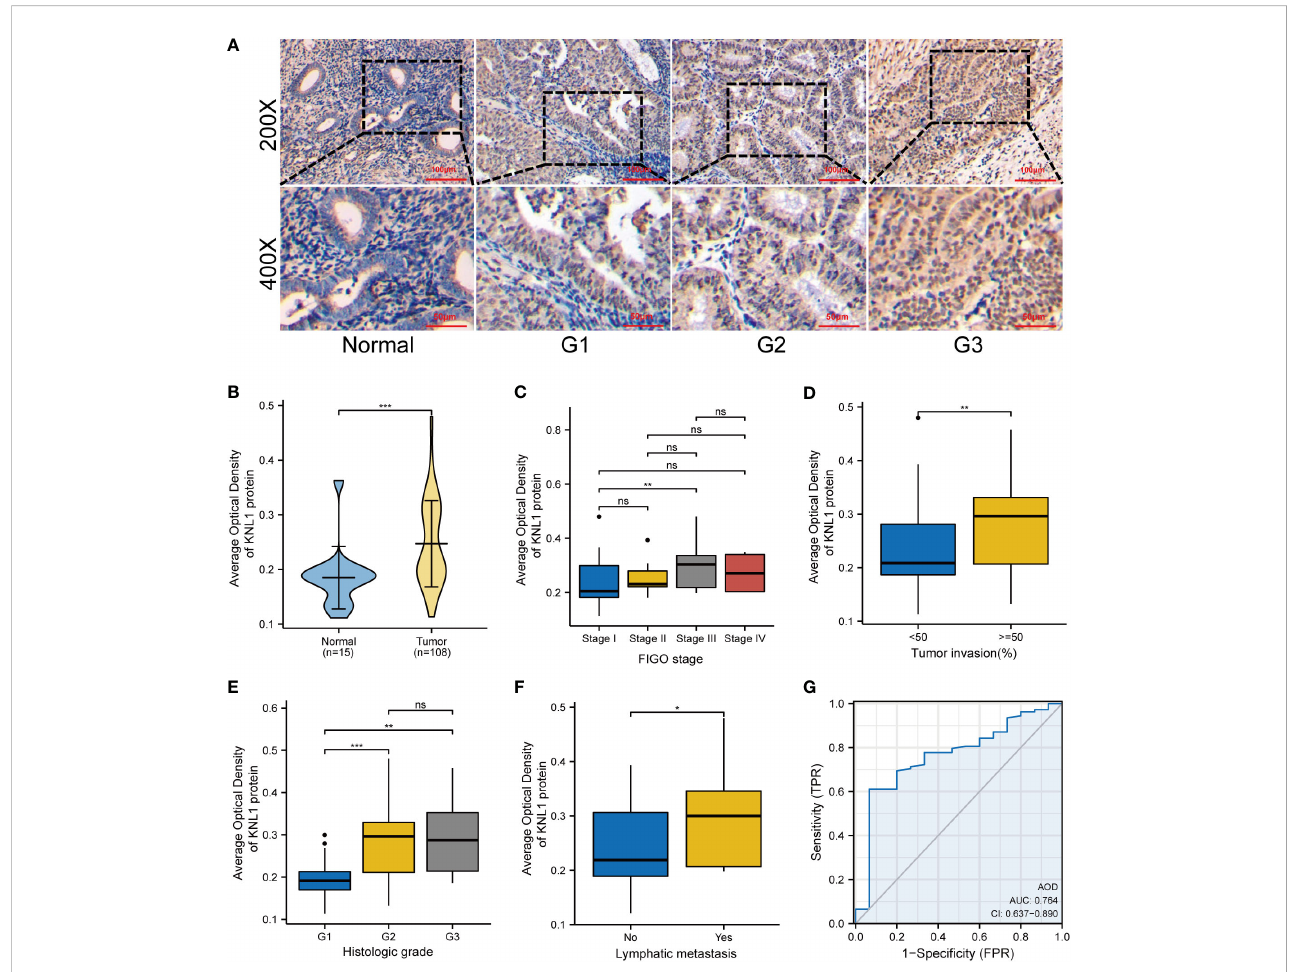
FIGURE 2 Expression and clinical correlation analysis of KNL1 in UCEC clinical samples. (A) Immunohistochemical results of KNL1 in normal endometrial tissues and UCEC tissues with different degrees of differentiation. (B) Group comparison of KNL1 immunohistochemical results in 108 UCEC clinical specimens and 15 normal endometrial cancer tissues. (C – F) Group comparison of KNL1 protein expression levels in samples with different clinical characteristics, (C) FIGO stage, (D) Tumor invasion, (E) Histologic grade, and (F) Lymphatic metastasis. (G) The diagnostic ROC curve of KNL1. Signi fi cance identi fi er: ns (no signi fi cance), p ≥ 0.05; *, p< 0.05; **, p<0.01; ***,